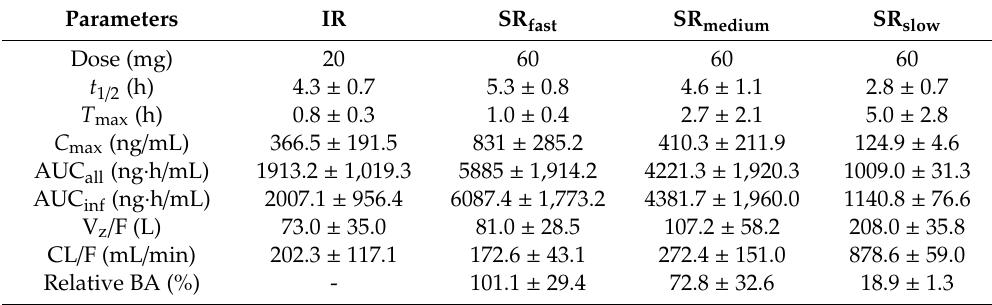
Figure 3. Average plasma concentration versus time profiles of sildenafil following oral administration of sildenafil (A) IR and (B) SR tablets ( n = 3, each). Table 2. Pharmacokinetic parameters of sildenafil obtained after oral administration of sildenafil IR and SR tablets in Beagle dogs ( n = 3, each).